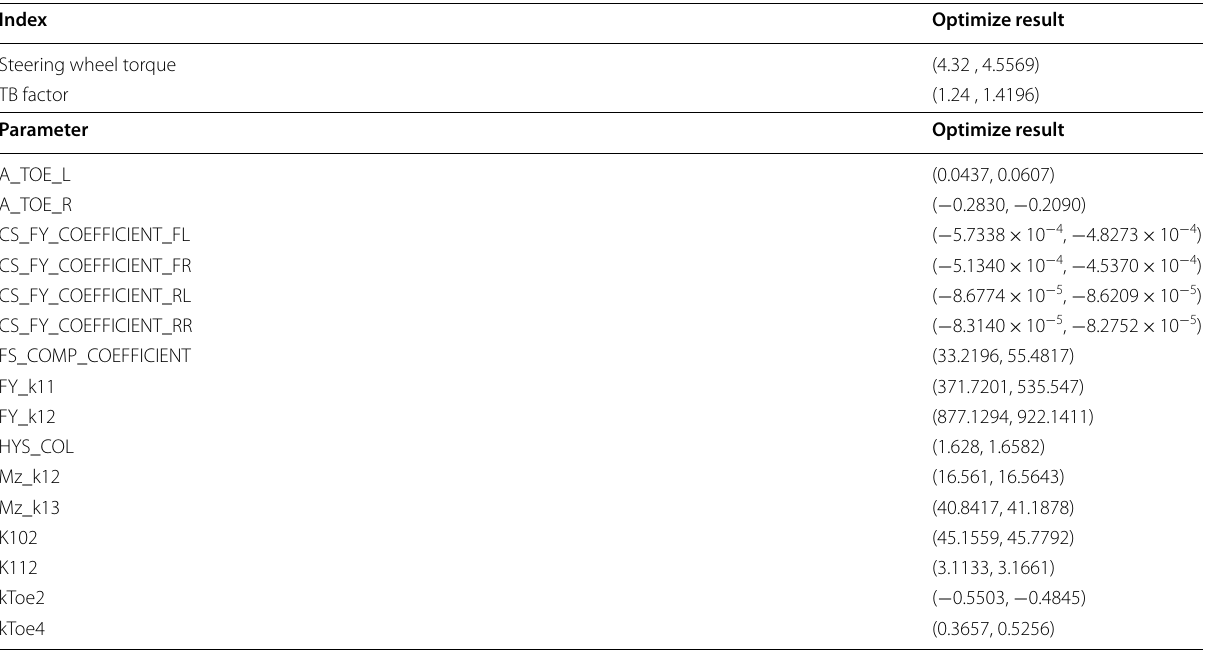
Table 5 Consistency analysis